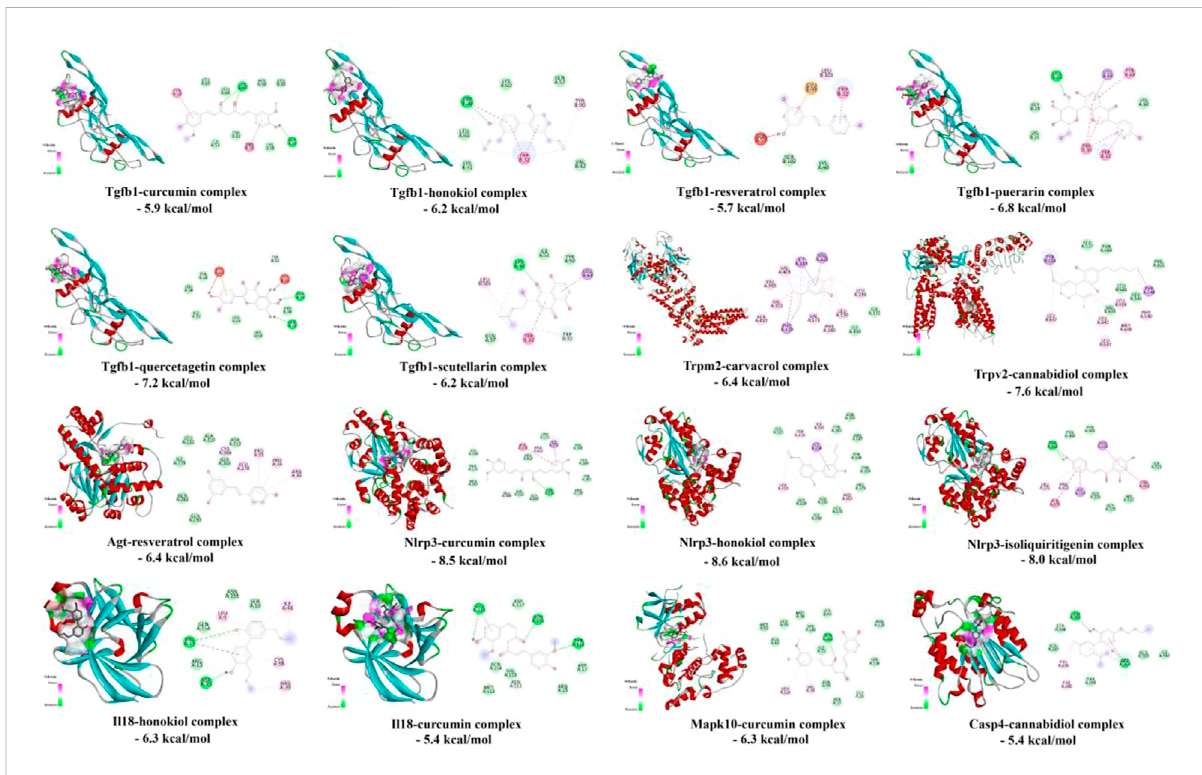
FIGURE 10 Molecular docking analysis of hub targets and